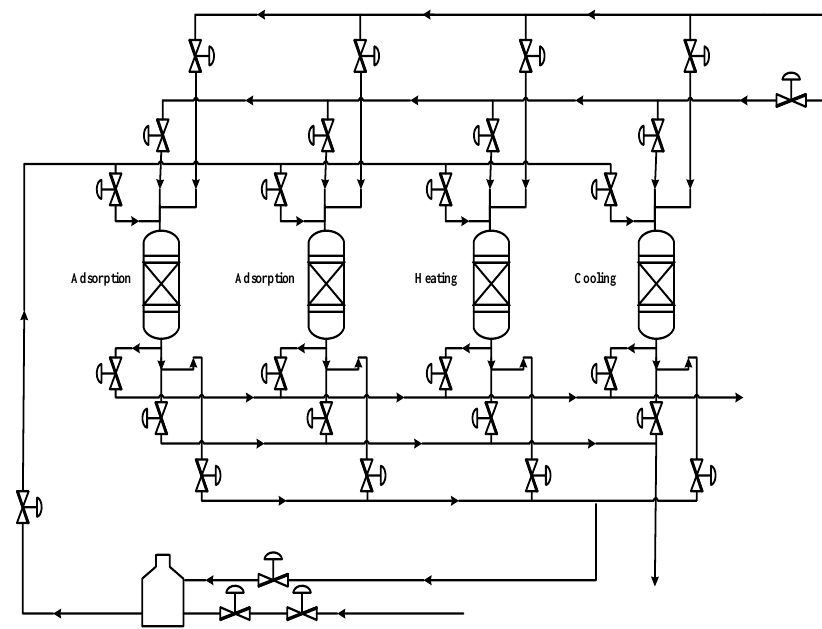
Figure 1. Schematic representation of the process with four beds. Table 1. Characteristics of adsorbents.